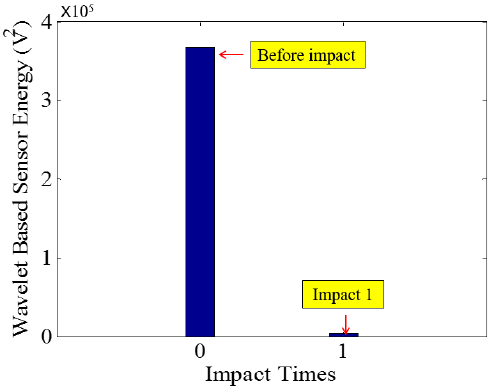
Figure 21. Wavelet packet-based energy plots of the received signal in Mortar-1. Figure 21 . Wavelet packet-based energy plots of the received signal in Mortar-1. Figure 21 . Wavelet packet-based energy plots of the received signal in Mortar-1. Figure 21 . Wavelet packet-based energy plots of the received signal in Mortar-1. Figure 21 . Wavelet packet-based energy plots of the received signal in Mortar-1.